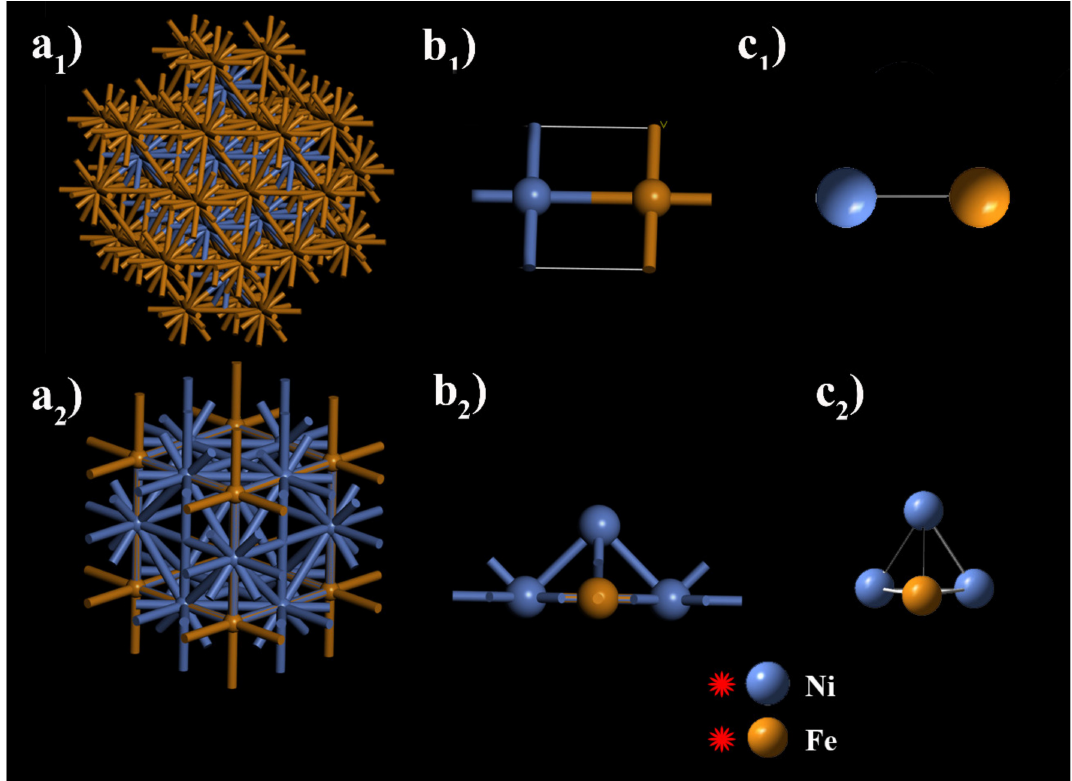
Figure 4. Comparison between outer most layer of catalyst and cluster structure: ( a( 1,2 ) ) crystal structure of catalyst, ( b( 1,2 ) ) outer most layer (100) of catalyst, ( c( 1,2 ) ) cluster